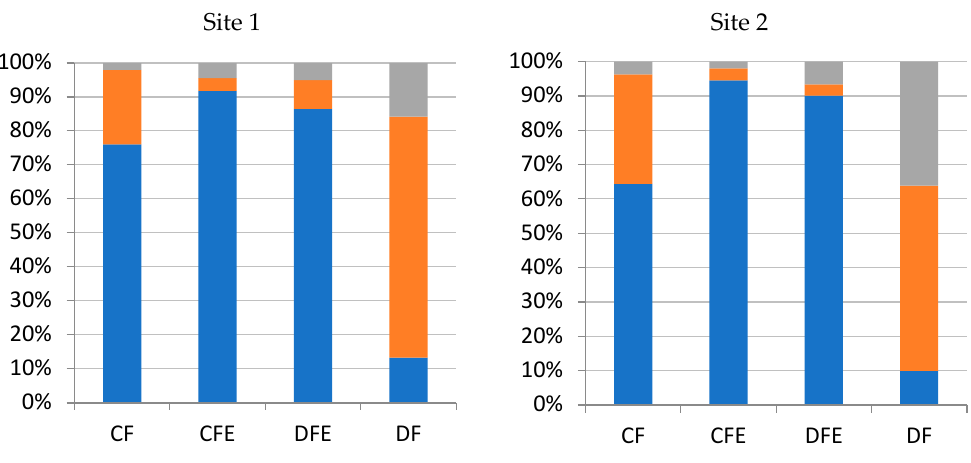
Figure 6. Relative contributions of species groups ( dwarf shrubs, forbs, grasses) to the